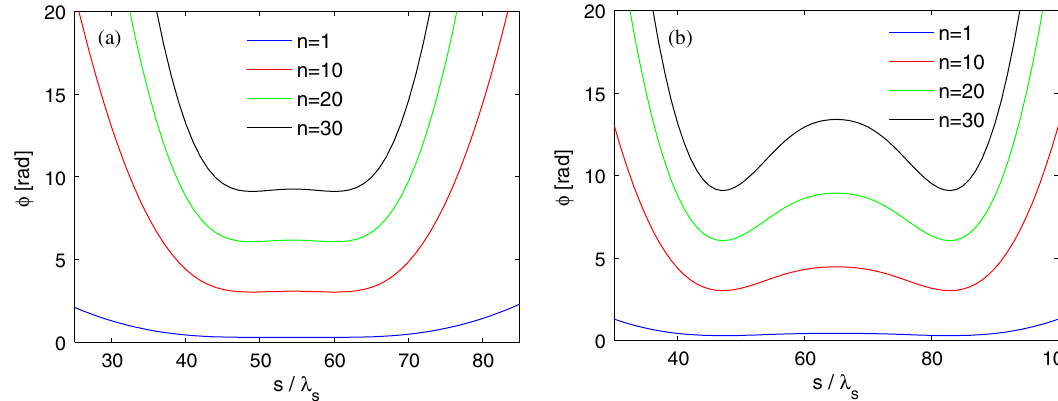
FIG. 7. Phase distributions of the bunching in UR at various harmonics ( n ¼ 1 , 10, 20, and 30) for different period numbers of the modulator: (a) N ¼ 30 ; (b) N ¼ 50